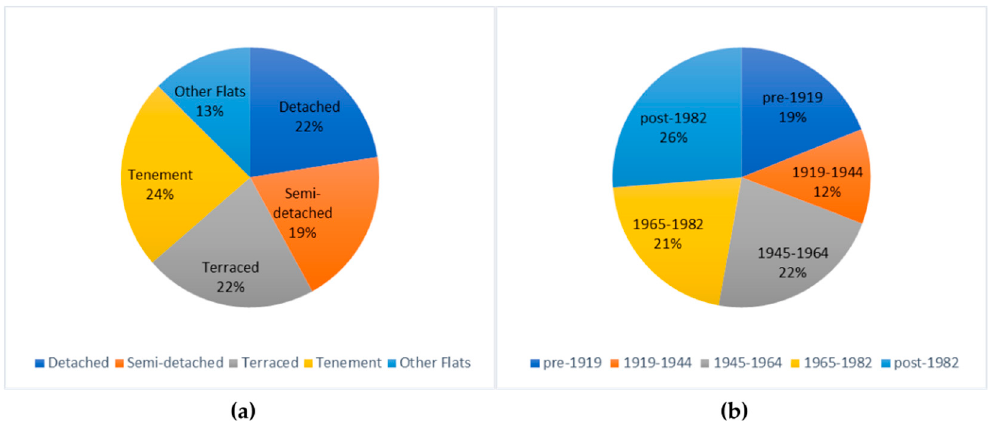
Figure 1. Breakdown of Scottish dwelling type by ( a ) number and ( b ) year built, in 2017 [3] .